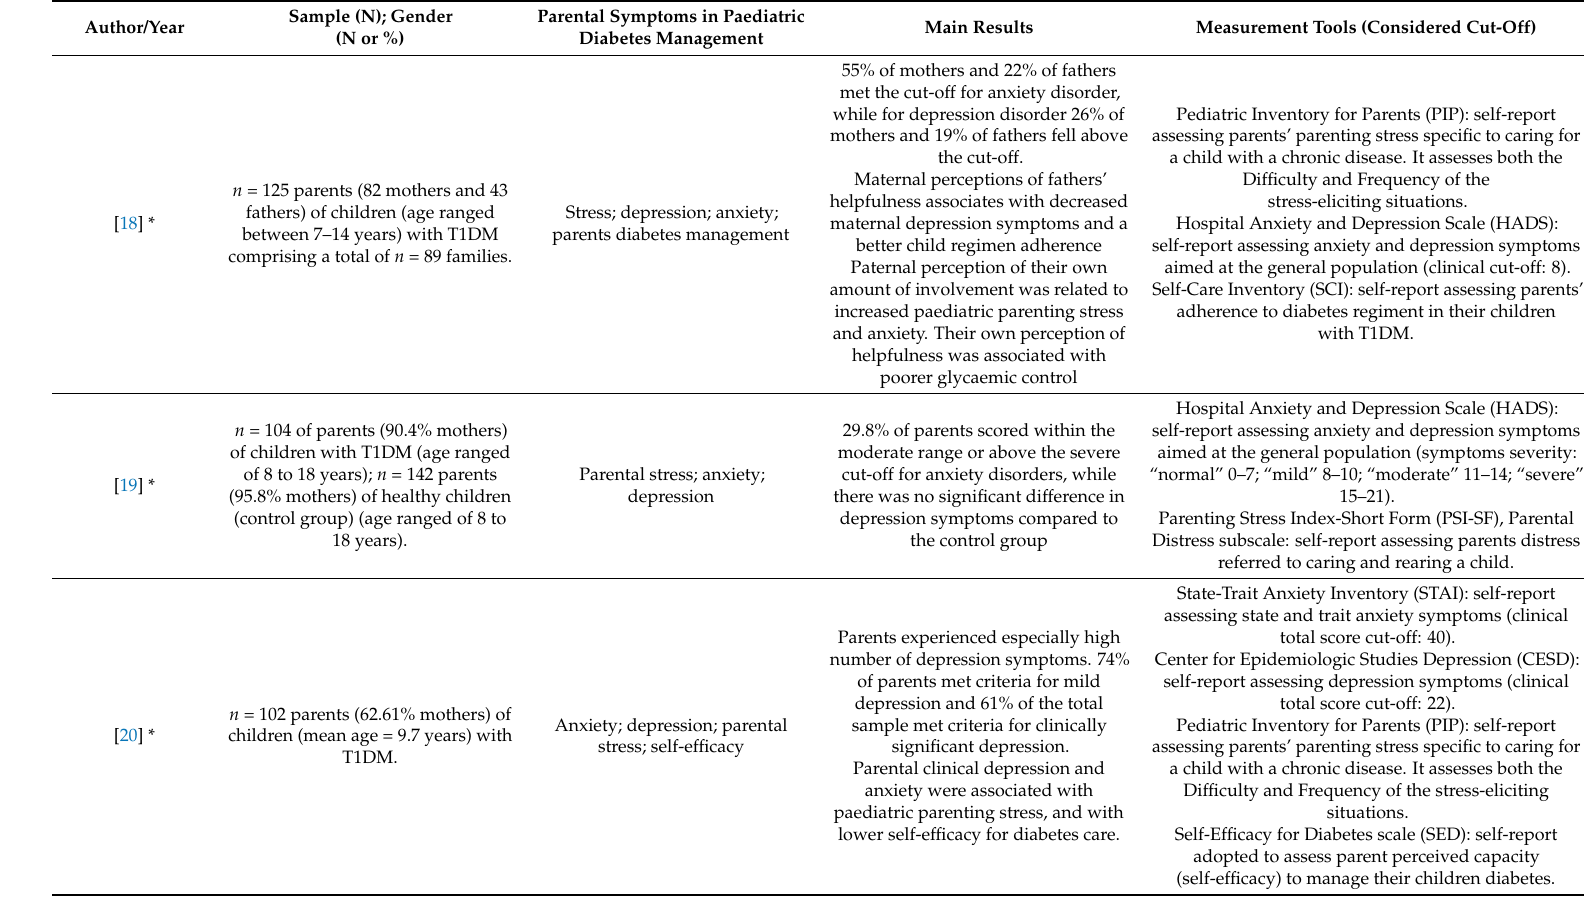
Table 1. Main characteristics of the 33 articles